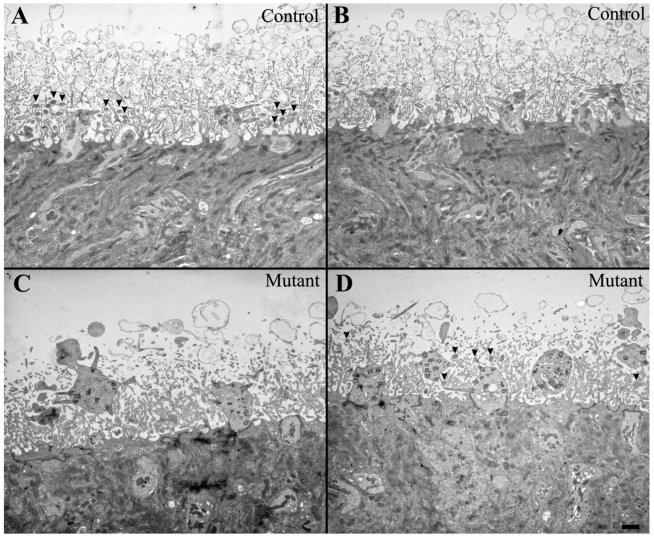
Swollen knobs and a decreased number of cilia are detected in mutant
MKS3 mutant rat olfactory epithelium.Representative olfactory epithelium images from normal (A, B) and MKS3
mutant (C, D) rats. Mutant sections showed enlarged OSN knobs, some of
which exhibited irregular shapes (e.g., to the left in C), with knobs
frequently appearing to be “detached” from the OE surface.
At this magnification, coronally sectioned OSN cilia could be
distinguished from microvilli as a result of their different sizes.
Control sections showed multiple easily identifiable cilia (arrowheads,
only shown in A), while mutant sections showed a decreased number
(arrowheads in D; none could be recognized in C). Scale bar
 = 1 µm: shown in (D) for A–D.